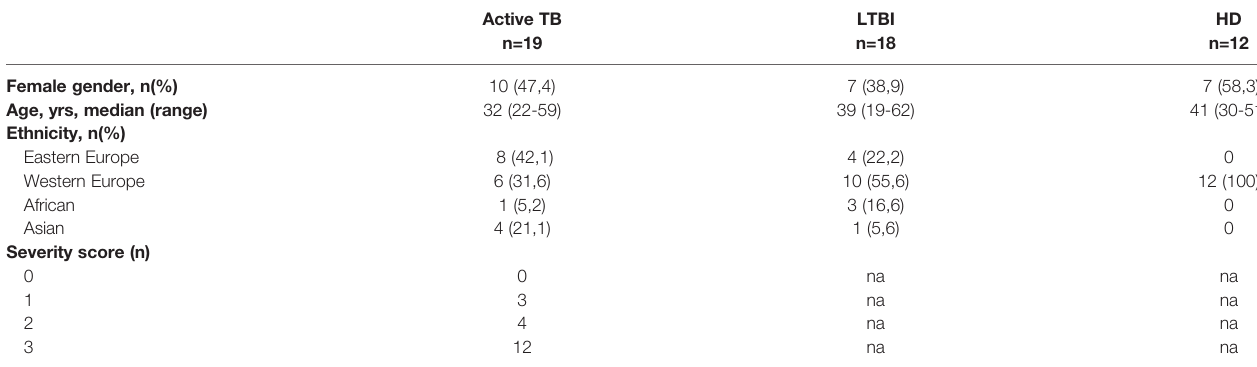
TABLE 1 | Patients